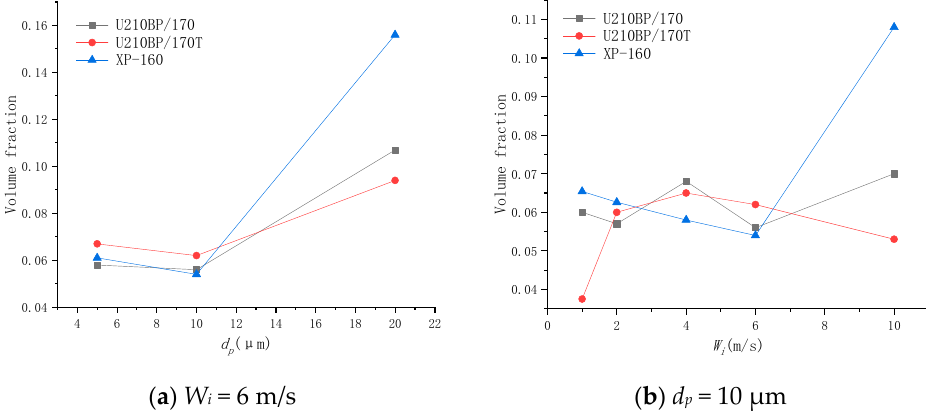
Figure 2. Simulation results: ( a ) the volume fraction with a different particle diameter; and ( b ) the volume fraction with a different wind speed.